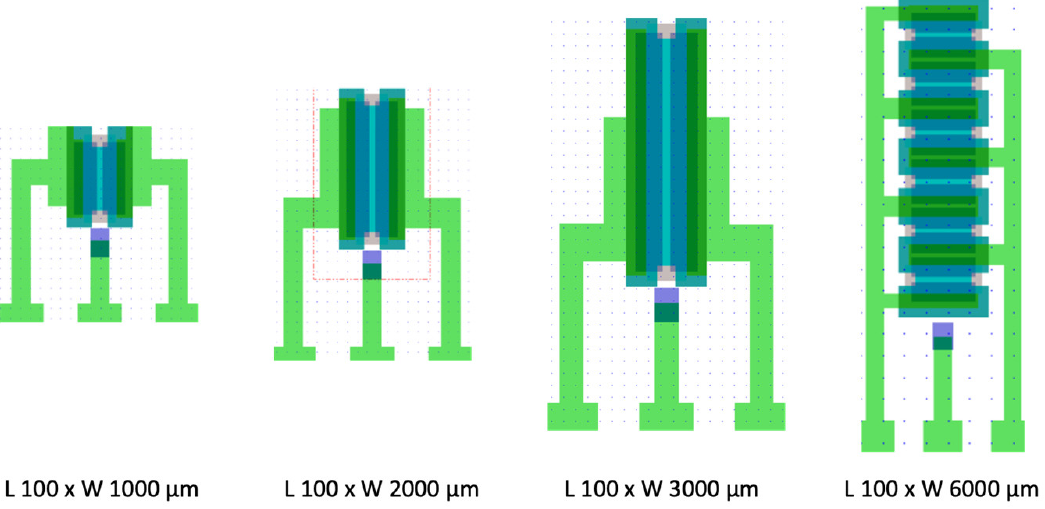
Figure 2. Driving OECT devices with different channel widths were evaluated in the presented work. The gate layer has been omitted to reveal the areas of interest.